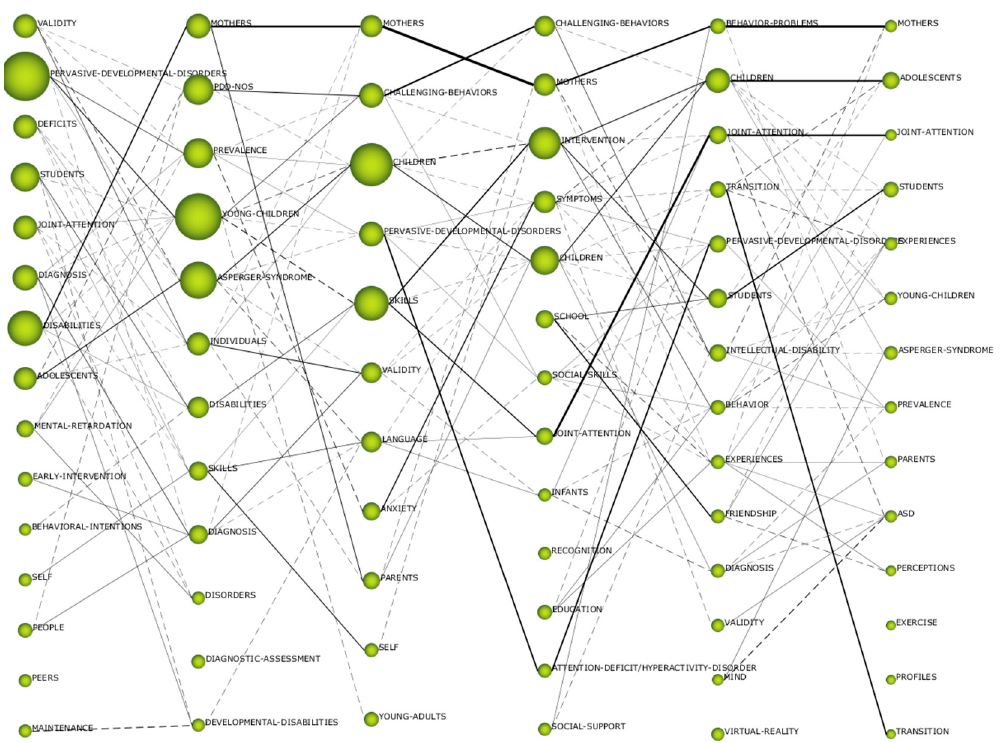
Figure 5. Thematic evolution by h index. Note : Continuous line (conceptual): thematic connection; discontinuous line (non-conceptual): keyword connection. Thematic columns, from left to right: column 1 (interval 1963–2008); column 2 (2009–2011); column 3 (interval 2012–2013); column 4 (interval